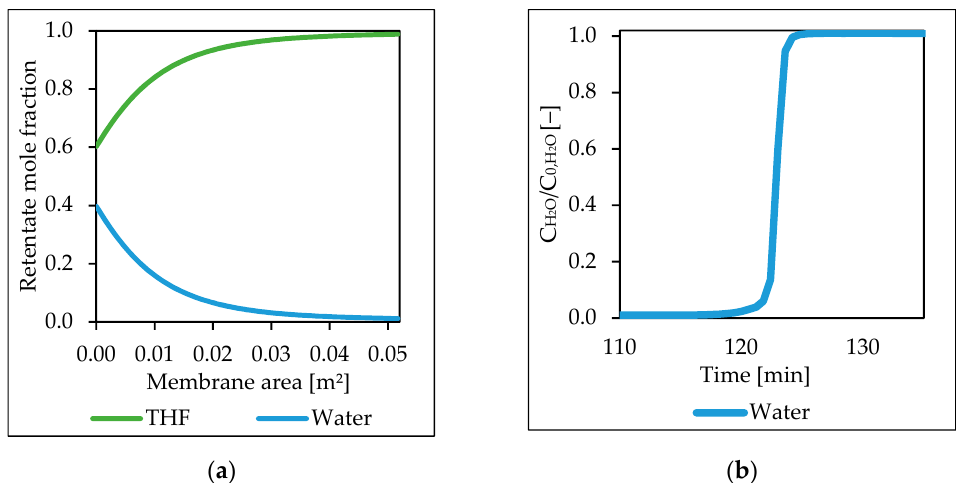
Figure 5. ( a ) THF mole fraction of the liquid and vapor phase inside the stripping column and ( b ) H 2 O mole fraction of the liquid and vapor phase inside the stripping column. As it can be inferred from the mole fractions, a large part of the purifica- tion can already be achieved with four stages.